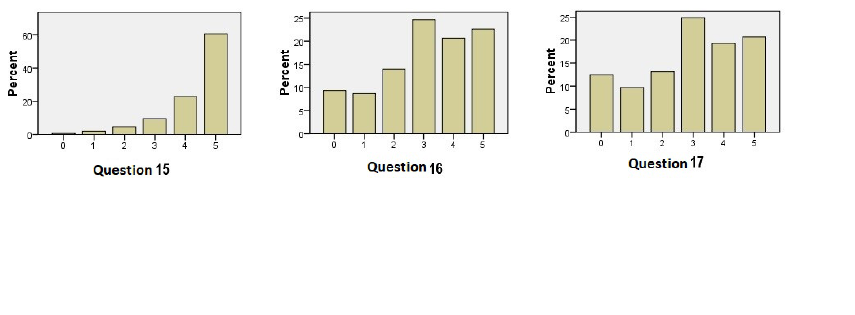
Figure 7: Question Category: Teacher